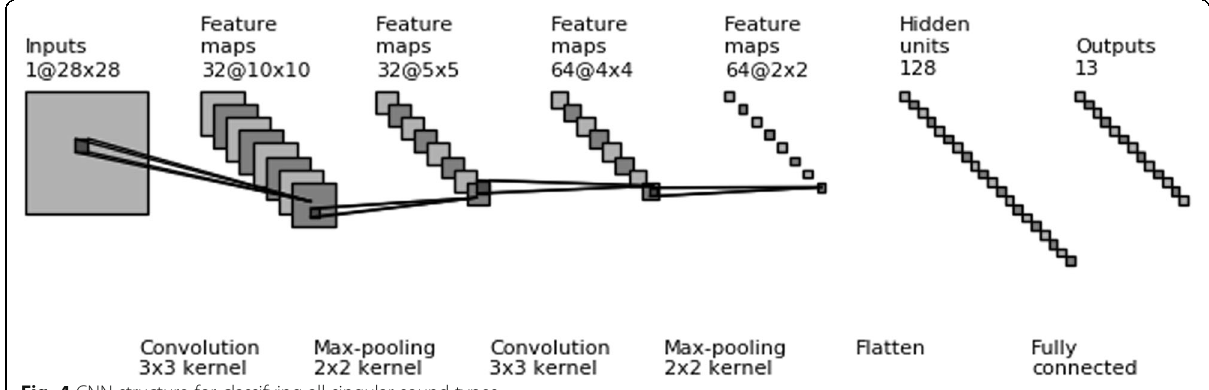
Fig. 4 CNN structure for classifying all singular sound